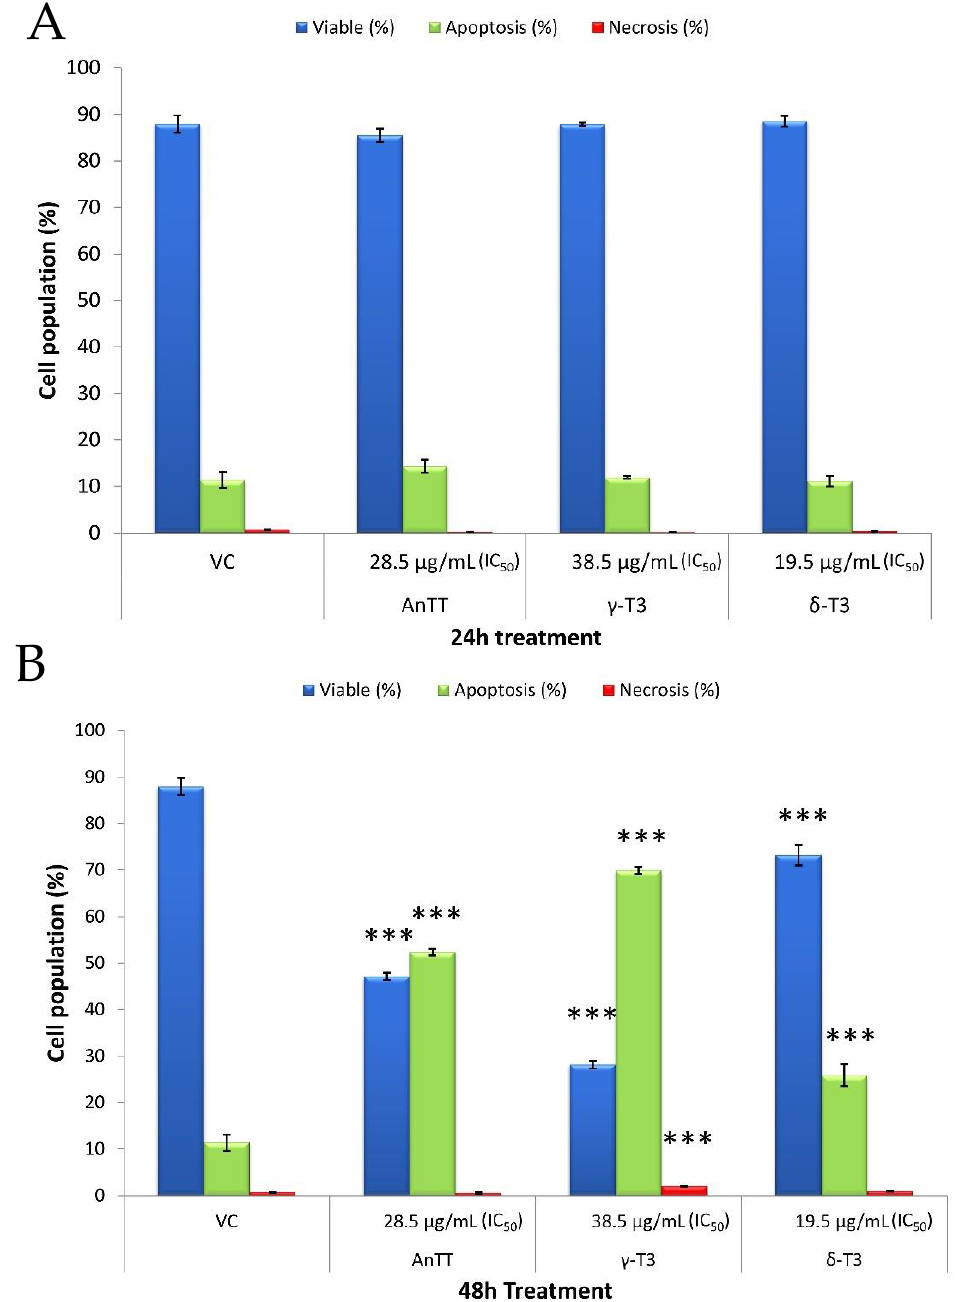
Figure 2. Mode of cell death in SW1353 cells over a 24 h ( A ) and 48 h ( B ) treatment with AnTT, γ -T3 and δ -T3 at their respective IC 50 . Although 24 h treatment of tocotrienols significantly reduces the viability of cells, they do not induce cell death. Tocotrienols-induced growth arrest during 24 h treatment is postulated. However, prolonging the treatment time to 48 h did induce significant cell death. *** indicate a significant difference of p < 0.001 compared to VC. Abbreviations: AnTT, annatto tocotrienol; δ -T3, δ -tocotrienol; γ -T3, γ -tocotrienol; IC 50 , half-maximal inhibitory concentration; VC, vehicle control.